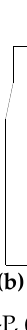
Figure 3. Specimen’s fabrication. ( a ): Fabrication process; ( b ) Strain gauges on SC-P, (unit: mm). Table 2. Pull-out test specimens (unit: